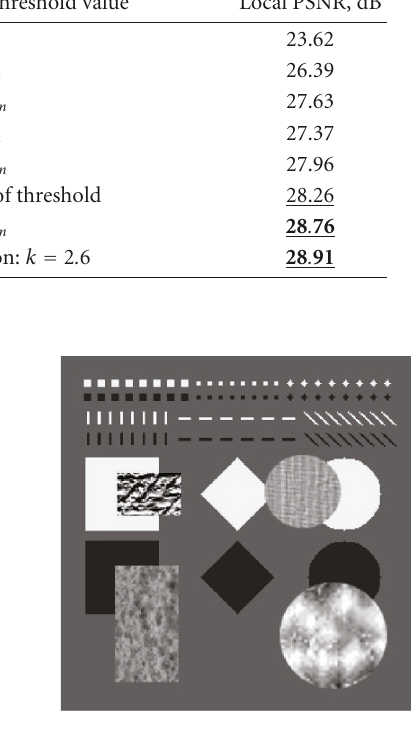
Figure 1: The noise-free test image with four texture regions (two of rectangular and two of circular